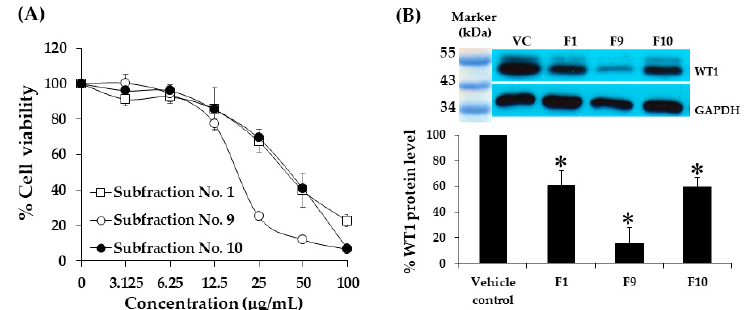
Figure 4. Cytotoxicity and WT1 inhibition of subfraction treatments on K562 cells. ( A ) The cells (1.0 × 10 5 cells / mL) treated with subfraction numbers 1, 9, and 10, for 48 h. Cell viability was determined using MTT assay. Each point represents mean ± SD of three independent experiments performed in triplicate. ( B ) The cells at a density of 1.0 × 10 5 cells/mL grown in a medium with 17.8, 10.0, and 16.6 µg/mL of subfractions 1, 9, and 10, respectively, for 48 h, 0.08% DMSO was used as a vehicle control. WT1 and GAPDH protein levels were determined using Western blot analysis, then the WT1 protein levels were measured and normalized using the GAPDH protein level. Data are expressed as mean ± SD of three independent experiments. Asterisk (*) demonstrates statistically significant di ff erence between the values of the vehicle control and the sample ( p < 0.05).